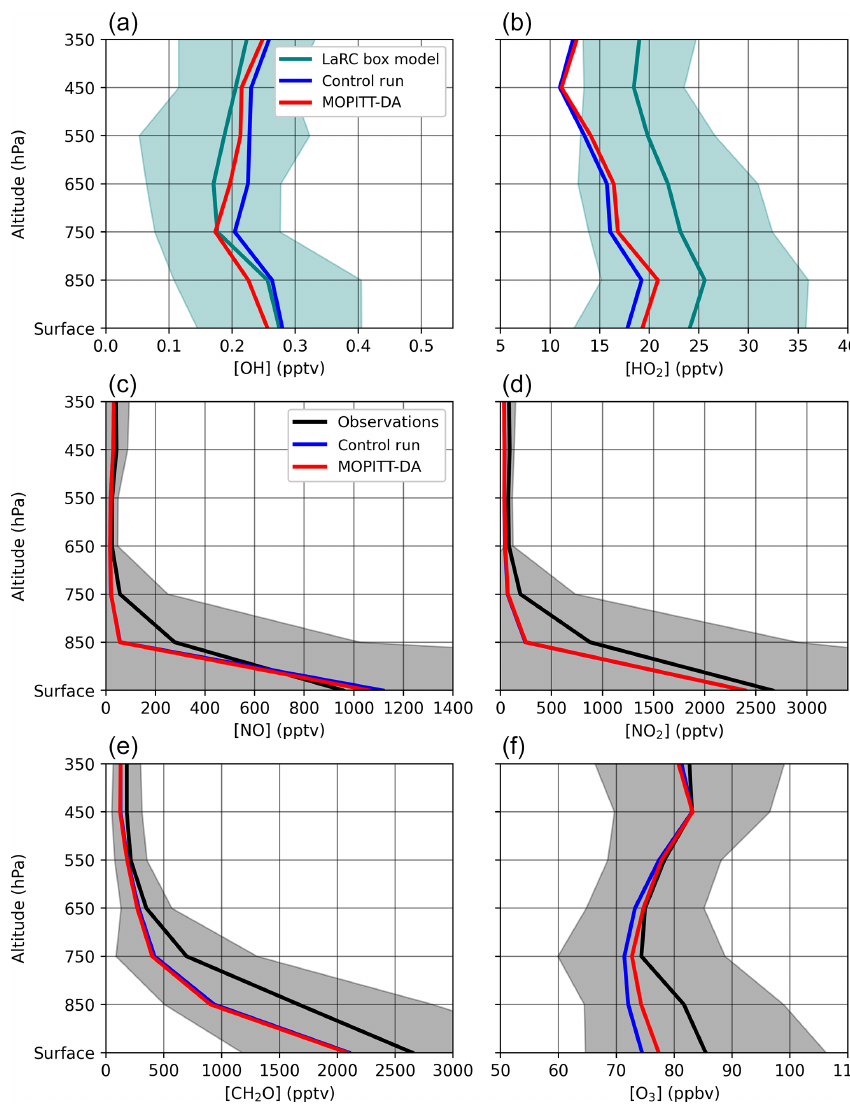
Figure 4. Average vertical profiles of OH (a) and HO 2 (b) for the 1s merge and the LaRC box model estimates (Schroeder et al., 2020). Results are shown for DC-8 1min merge observations for NO (c) , NO 2 (d) , CH 2 O (e) , and O 3 measurements (f) . The shaded area corresponds to the standard deviation around the observed